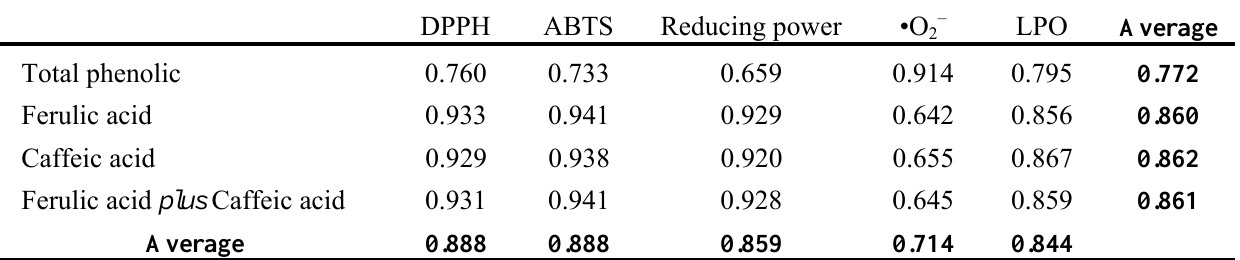
Table 4. The R values (correlation coefficients) between antioxidant activities (1/IC phenolic